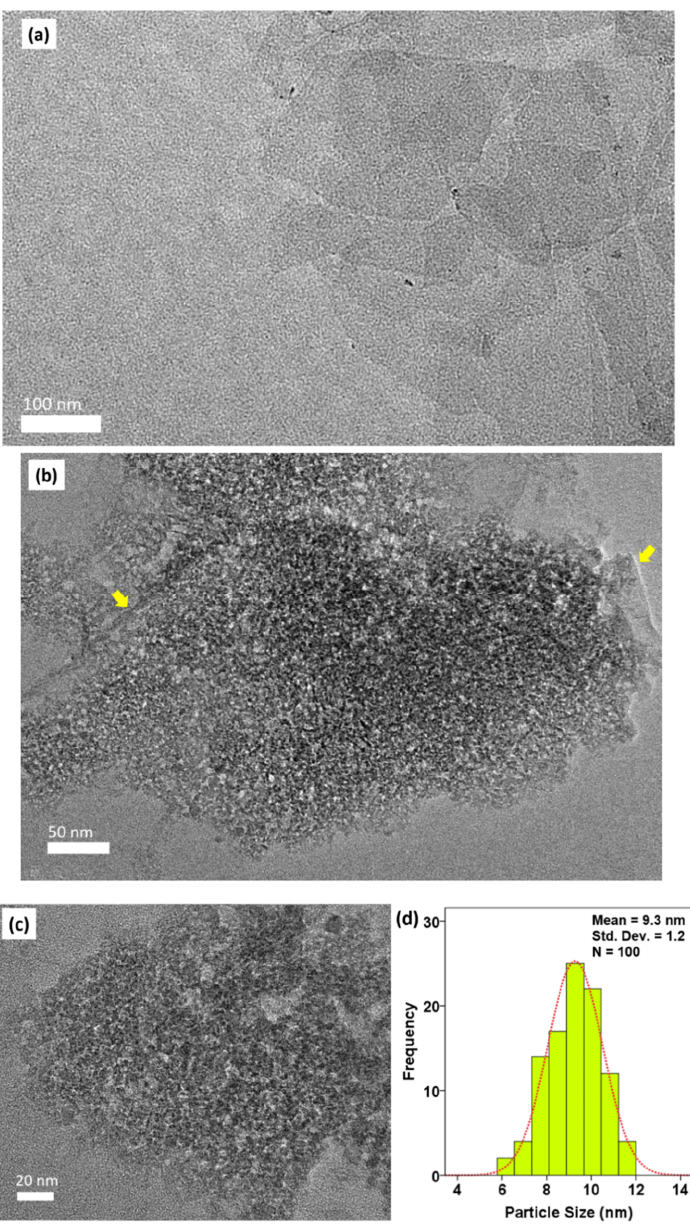
Figure 3. TEM images of ( a ) pristine MMT, scale bar represents 100 nm; ( b ) MMT/CR/Fe 3 O 4 -NCs at higher magnification, scale bar represents 50 nm, yellow arrows show the depositing of Fe 3 O 4 -NPs on the lamellar structure of MMT; and ( c ) MMT/CR/Fe 3 O 4 -NCs at lower magnification, scale bar represents 20 nm; ( d ) Size distribution histogram of MMT/CR/Fe 3 O 4 -NCs. Figures 3(b) and (c) show the TEM images of MMT/CR/Fe 3 O 4 -NCs at higher and lower magnification, respectively. In Figure 3(b), Fe 3 O 4 -NPs were deposited on the lamellar structure of